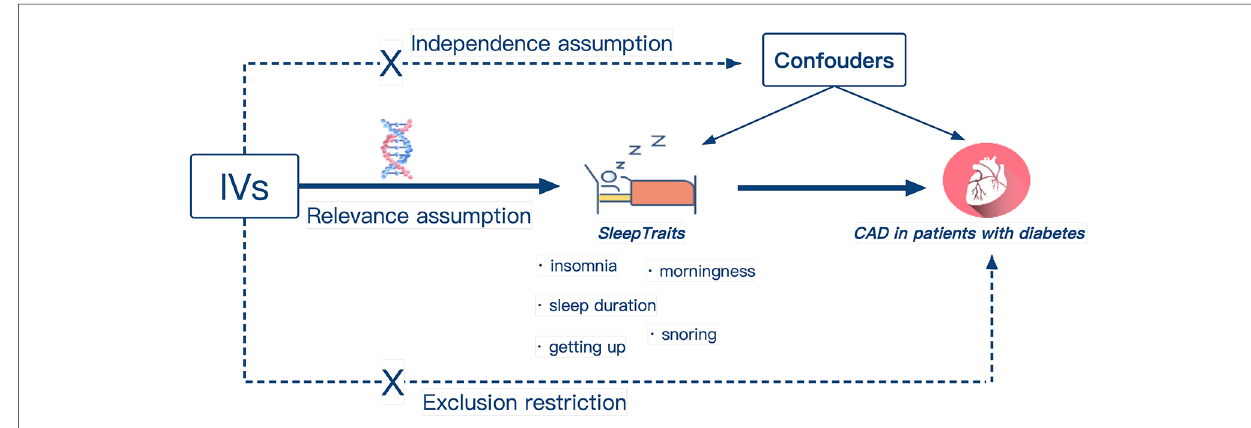
FIGURE 1 Design of the Mendelian randomization study. Three core assumptions were as follows: Relevance assumption, the genetic IVs must be associated with sleep traits; Independence assumption, IVs should not be associated with confounders; Exclusion restriction, IVs must in fl uence CAD in patients with diabetes only via sleep traits. IVs, instrumental variables; Easy to get up, ease of getting up in the morning; CAD, coronary artery disease.